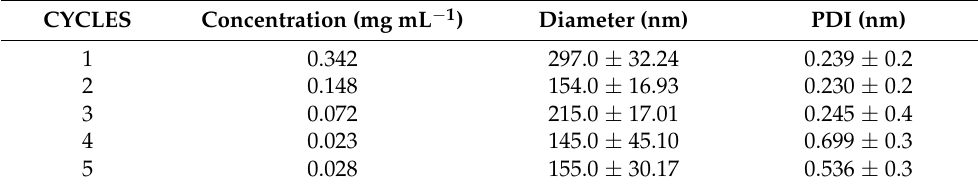
Table 9. The concentration of MIP nanoparticles after different cycles using denatured trypsin in the